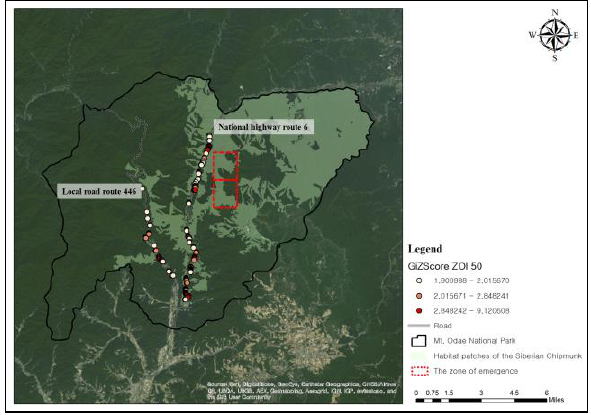
Figure 1. Habitat patches and Road-kill Hotspots of the Siberian Chipmunk in Mt. Odae National